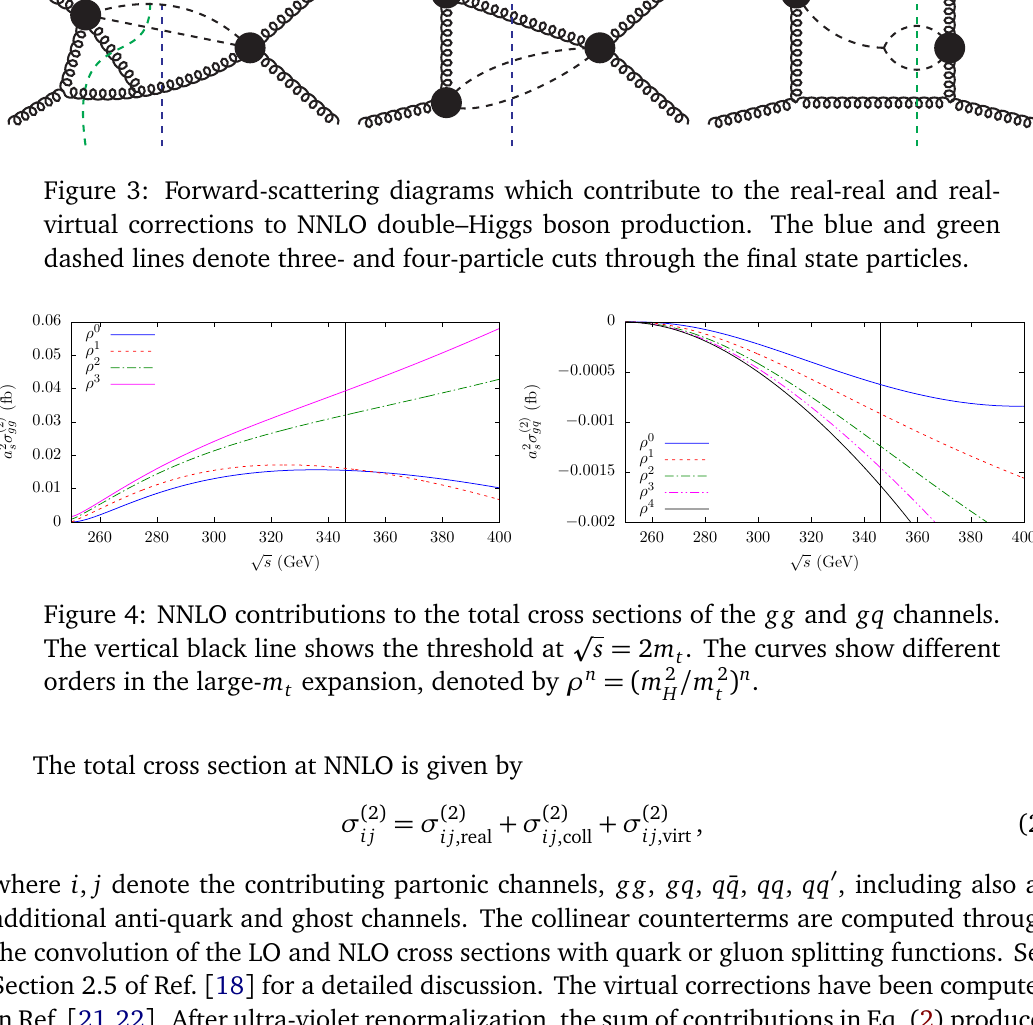
expansion, denoted by ρ n = ( m 2 t